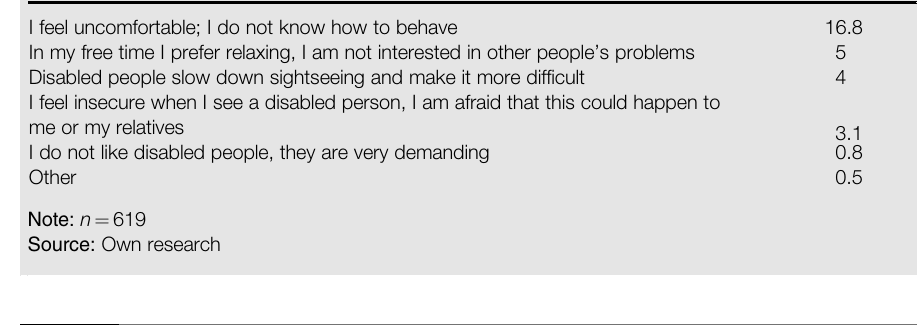
Table VI Types of support for tourism of PwD according to respondents (in per cent)